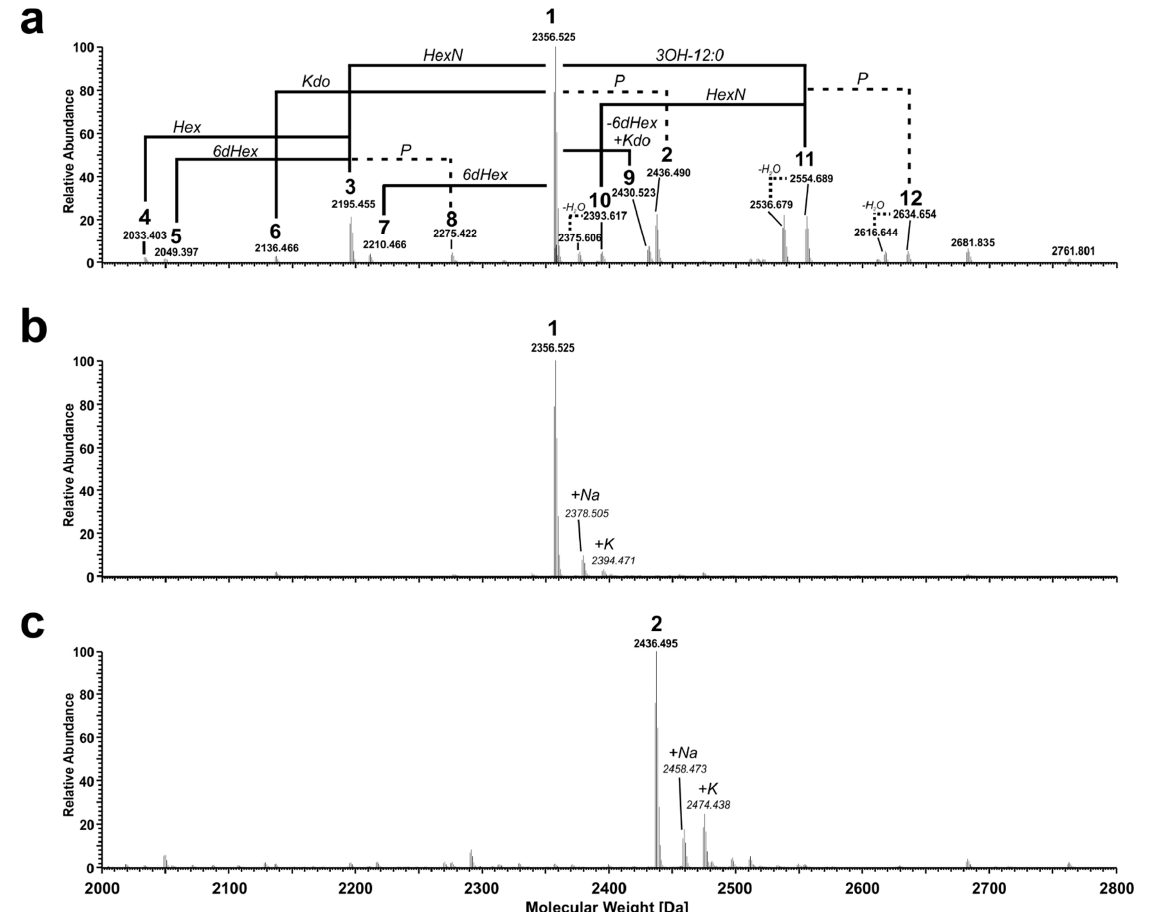
Figure 3. Mass spectrometric analysis of the O- and N-deacylated core-LA carbohydrate backbone of Pst DC3000 Δ wbpL . ( a ) Molecular species distribution in the mixture of oligosaccharides obtained after hydrazinolysis and alkaline hydrolysis (OS-HyKOH). The charge-deconvoluted spectrum of the MS-analysis performed in negative ion mode is depicted; the observed molecular species are listed in Table 2. MS-spectra of selected pools from the further fractionation by HPAEC containing molecules 1 ( b ) and 2 ( c ), respectively. Molecular masses given in italic style represent sodium ( Δ m = 21.98 Da) or potassium ( Δ m = 37.95 Da) adduct ions of the respective base peak. Table 2. Mass spectrometric analysis of the O- and N-deacylated core-LA carbohydrate backbone of Pst DC3000 ∆ wbpL . Summary of calculated monoisotopic neutral masses and observed molecular masses [Da] in the OS-HyKOH preparation, the corresponding MS spectrum is depicted in Figure 3a. Accuracy of the measurement is stated as ∆ ppm; anh = anhydro. Molecule Composition Calculated Mass [Da] Observed Mass [Da] Error